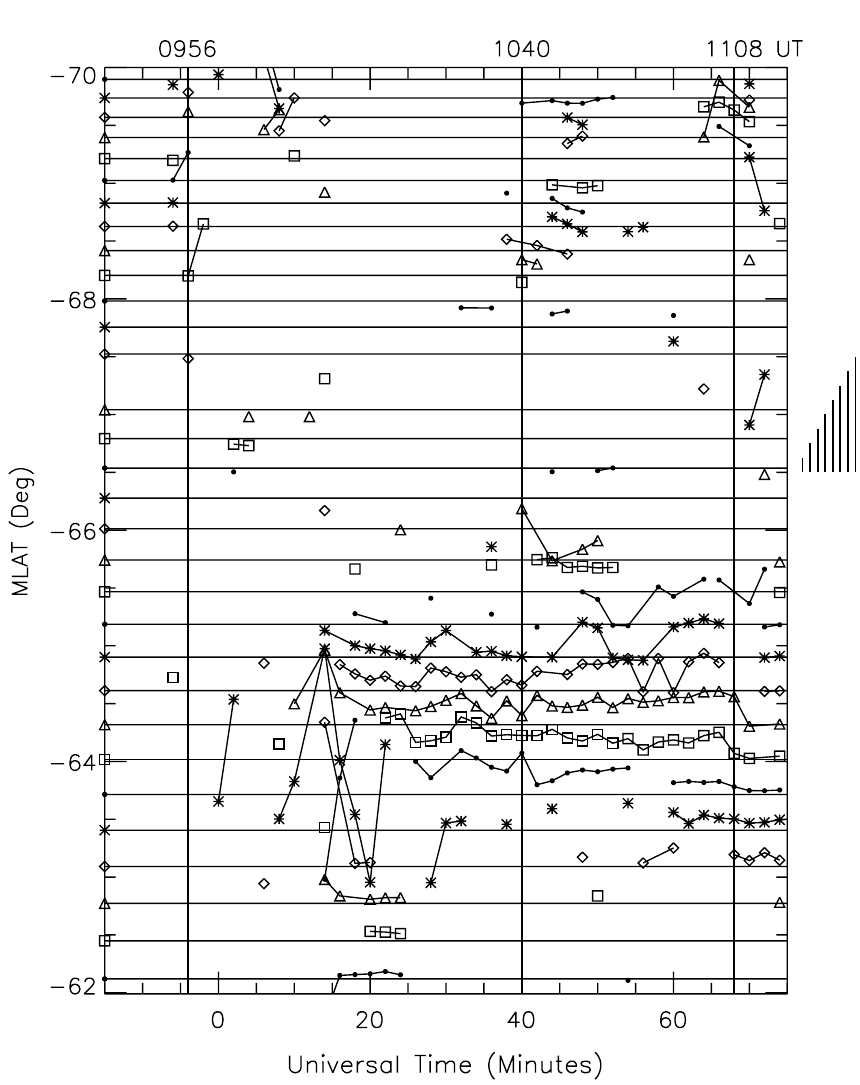
Fig. 6a. Refined beam-swinging analysis (see text) using the LOS Doppler velocities recorded on beam 15 (east). Alternating symbols were used for velocities calculated at different magnetic latitudes and are identified by the symbol superimposed on the left ordinate at the corresponding latitude (e.g. open squares represent velocities at − 64 ◦ 3 ). The scale used was 4kms − 1 per 1 ◦ 3 , and the ascending scale at right shows speeds of 500, 1000,..., 4000ms − 1 . The time base is in minutes, commencing at 10:00UT, and the abscissa has tick marks at 5-min intervals of